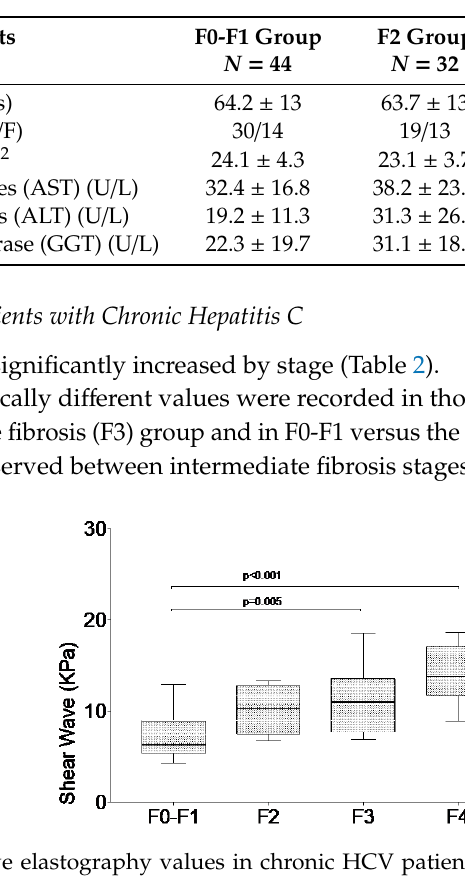
Table 1. Baseline characteristics of the study population.